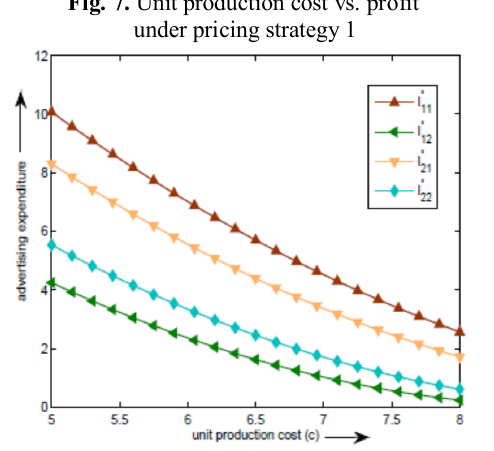
Fig. 10. Participation rate vs. profit under pricing strategy 1